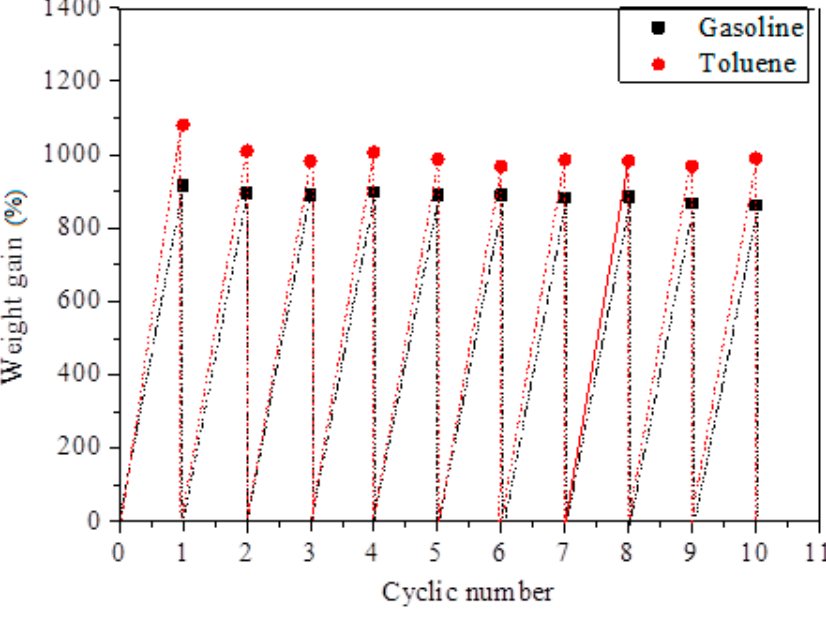
Figure 14. The cyclic adsorption capacity of sample SCA for gasoline and toluene.